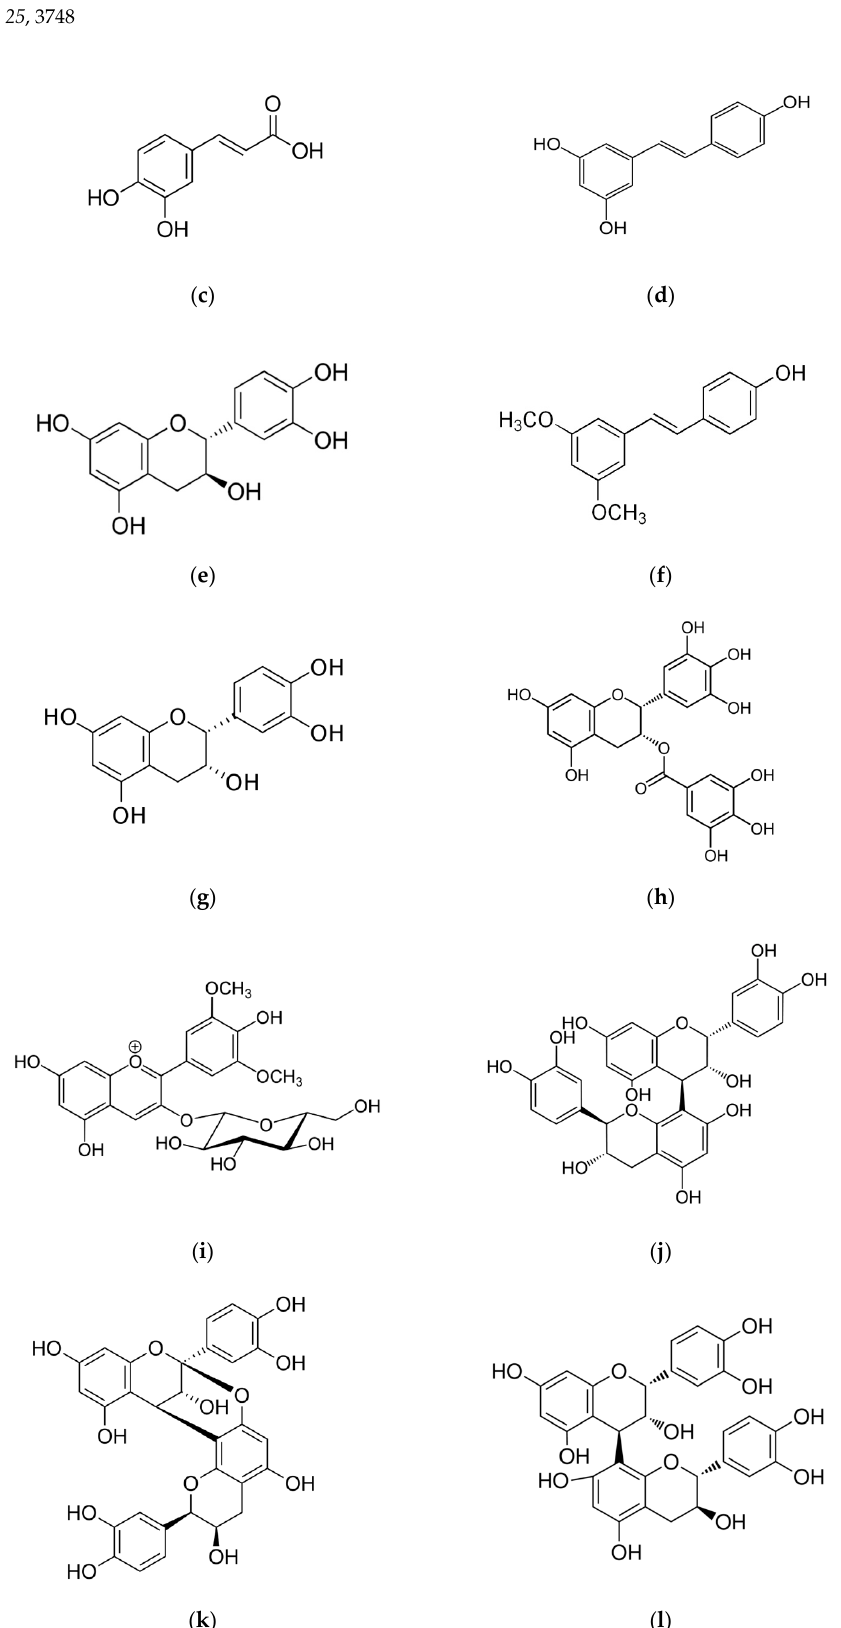
Figure 1. Structures of major phenolic and polyphenolic compounds with antifungal activity identified in di ff erent matrices of V. vinifera, ( a ) gallic acid, ( b ) quercetin, ( c ) ca ff eic acid, ( d ), resveratrol, ( e ) catechin, ( f ) pterostilbene, ( g ) epicatechin, ( h ) epigallocatechin-3-gallate, ( i ) malvidin-3-O-glucoside, ( j ) procyanidin B1, ( k ) procyanidin A2 and ( l ) procyanidin